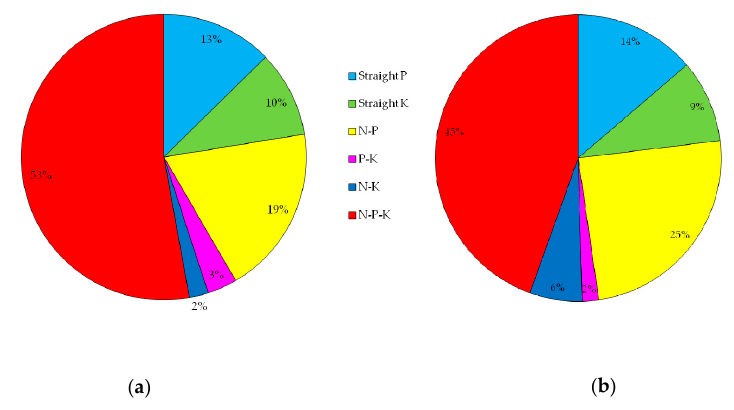
Figure 1. Distribution of fertilizers used in 2015 by types [20]: ( a ) Veneto; ( b ) Italy.